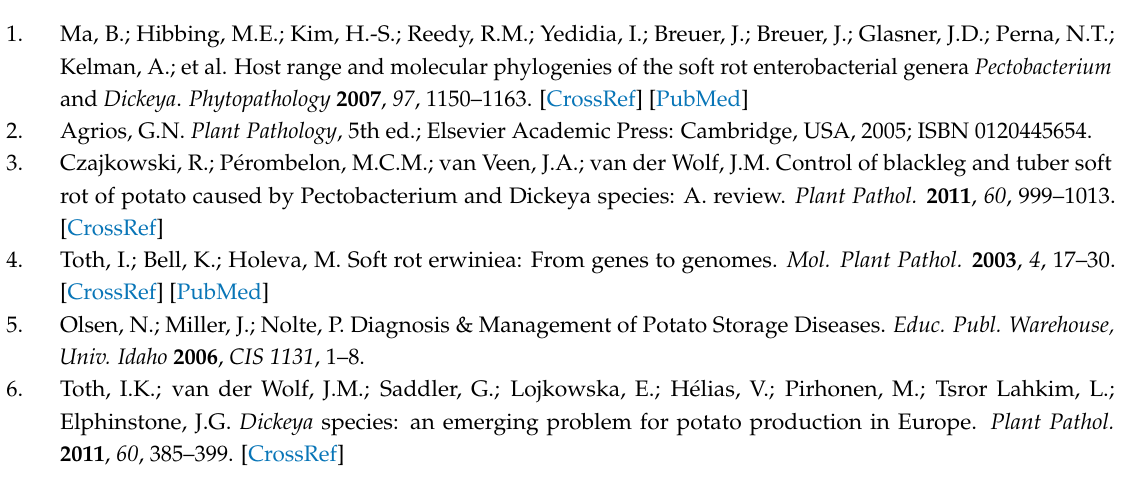
similarity, red being more dissimilar and violet being more similar. Colored boxes represent genes; Table S1: Isolation source of the 46 isolated